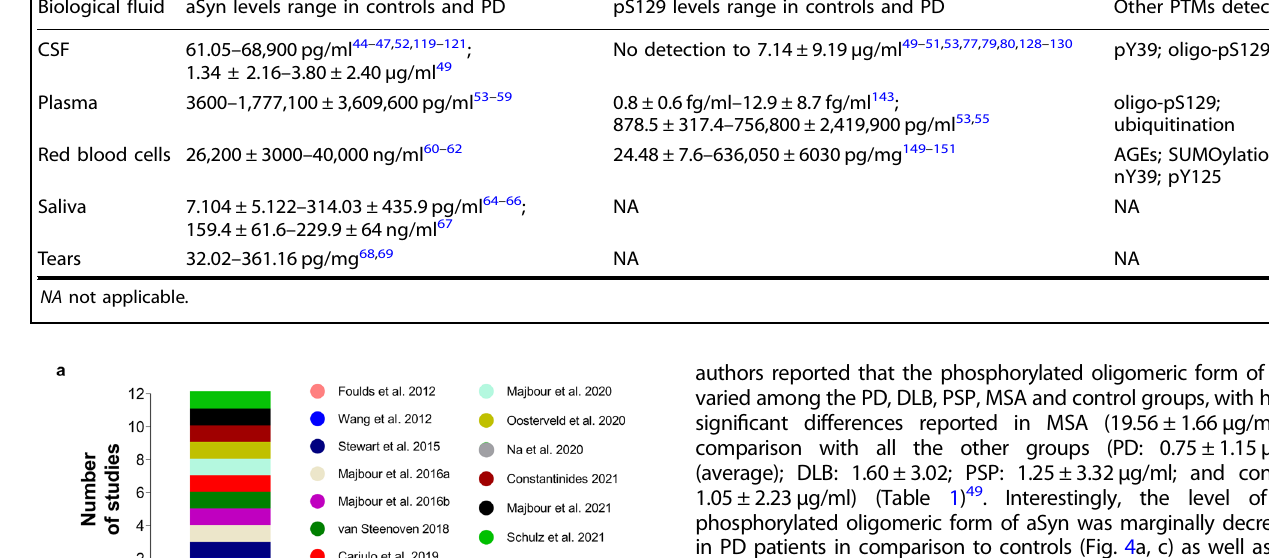
Table 2. Overview of the concentration of unmodi fi ed aSyn and pS129 aSyn in the different biological fl uid specimens. Biological fl uid aSyn levels range in controls and PD pS129 levels range in controls and PD